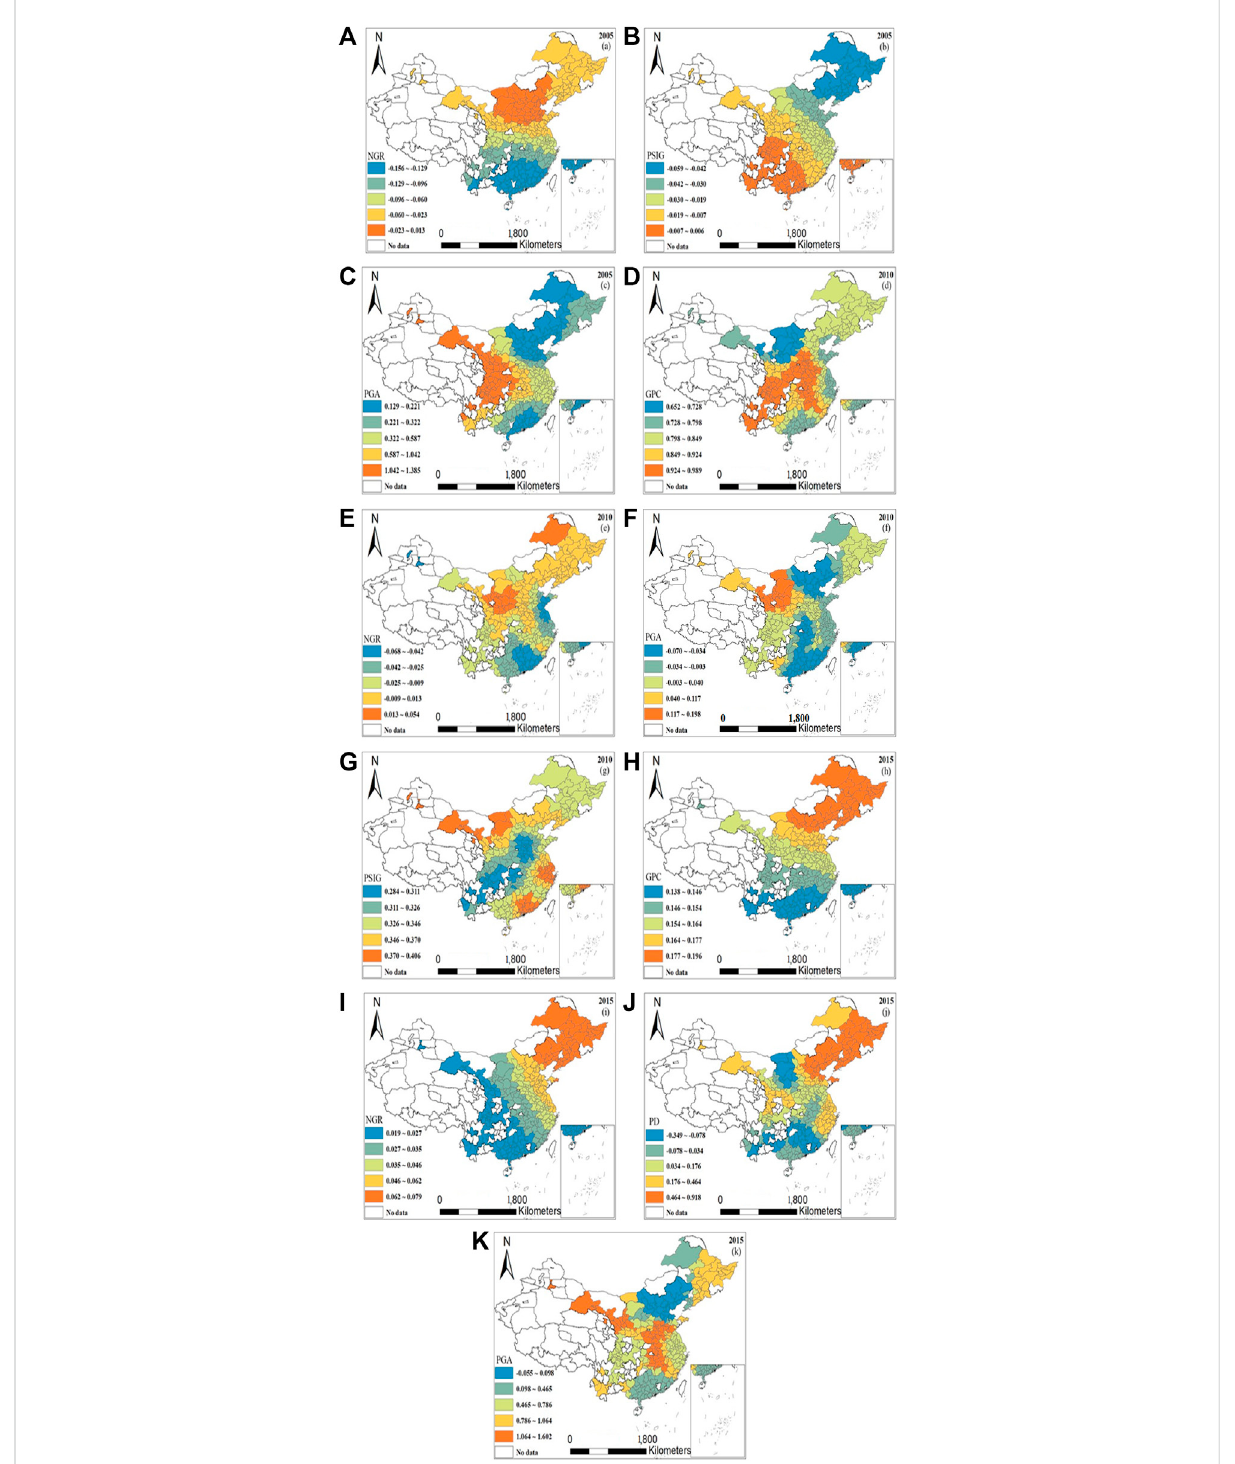
Spatial distribution of variable coef fi cients of the MGWR. (A) for NGR (2005), (B) for PSIG (2005), (C) for PGA (2005), (D) for GPC (2010), (E) for NGR (2010), (F) for PGA (2010), (G) for PSIG (2010), (H) for GPC (2015), (I) for NGR (2015), (J) for PD (2015), (K) for PGA